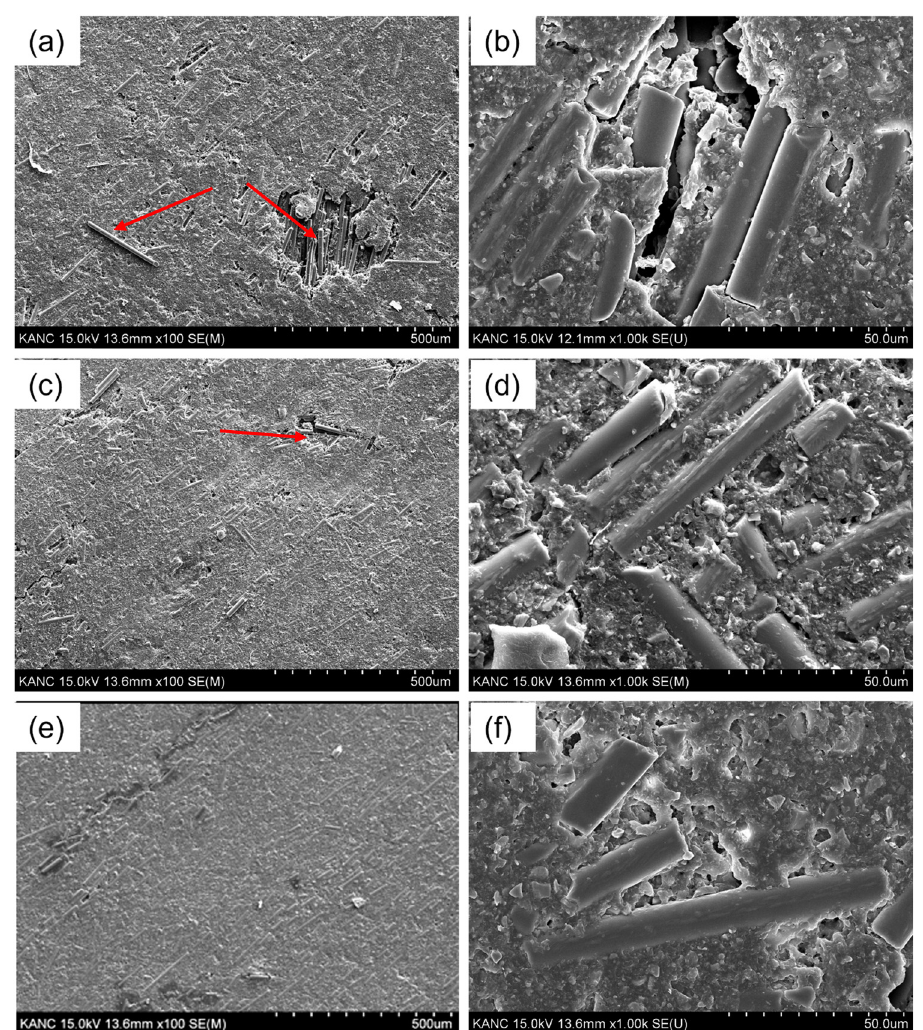
Figure 9: FE - SEM image of wear tracks of ( a and b ) basalt/epoxy, ( c and d ) GO + epoxy/basalt, and ( e and f ) rGO@Basalt/epoxy